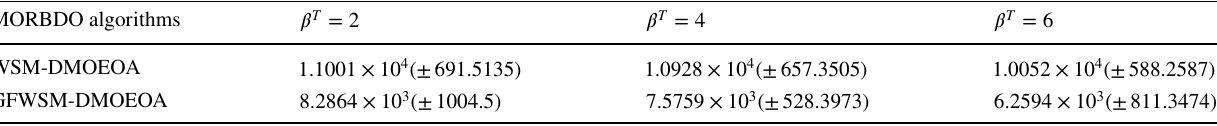
Table 11 The computational time (s) of the two MORBDO algorithms on the second MORBDO test example with different target reliability lev- els. Each result is in the form of mean ± standard deviation MORBDO algorithms